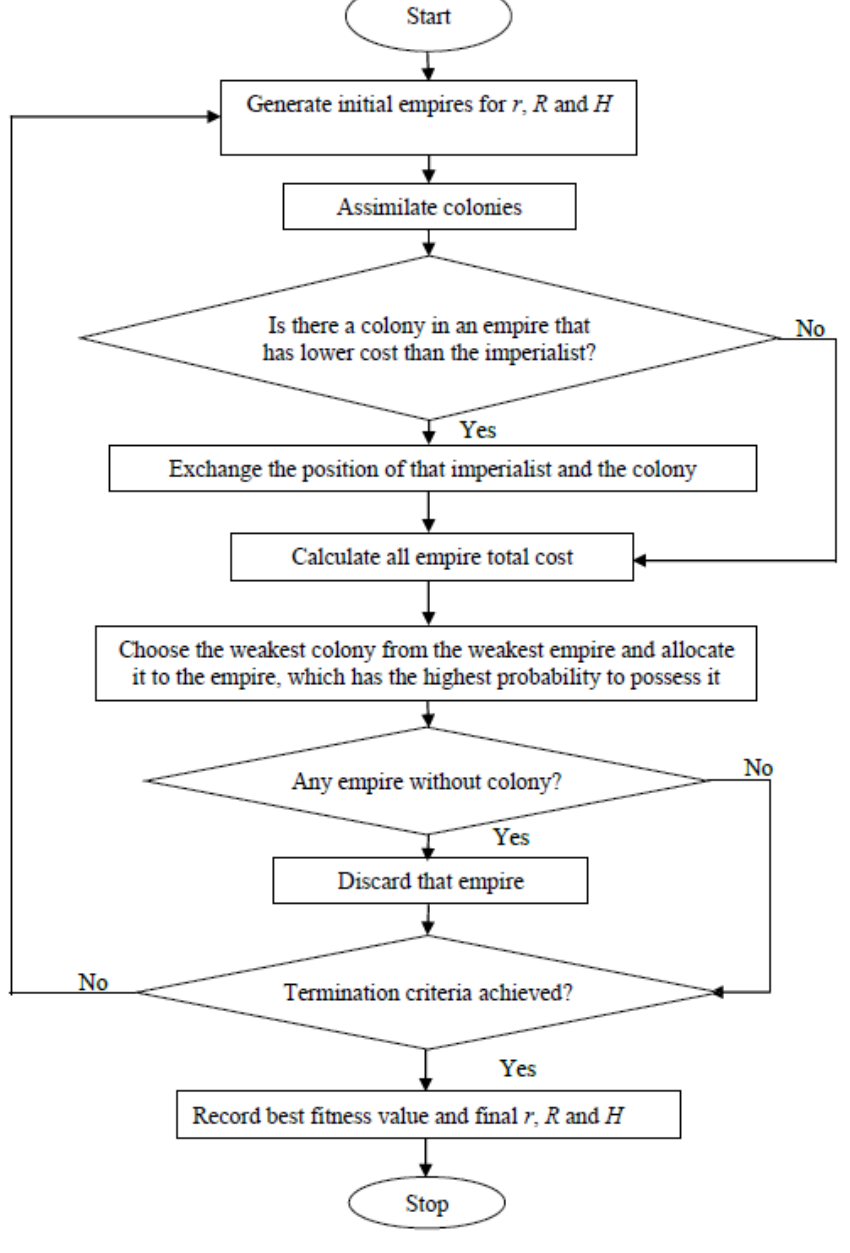
Figure 5. Flowchart of ICA.